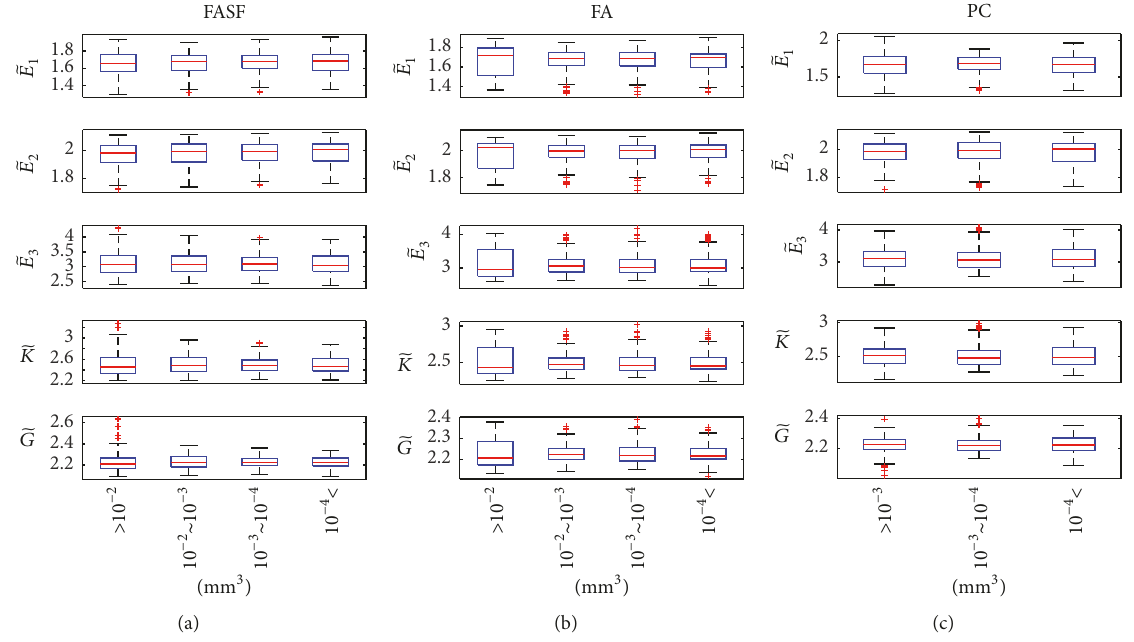
̃𝐸 , ̃𝐸 , ̃𝐸 , ̃𝐾, ̃𝐺 )oftheelasticmoduli predicted by the4-factorPCCmodel: (a)fourpore-volume ranges 1 2 3